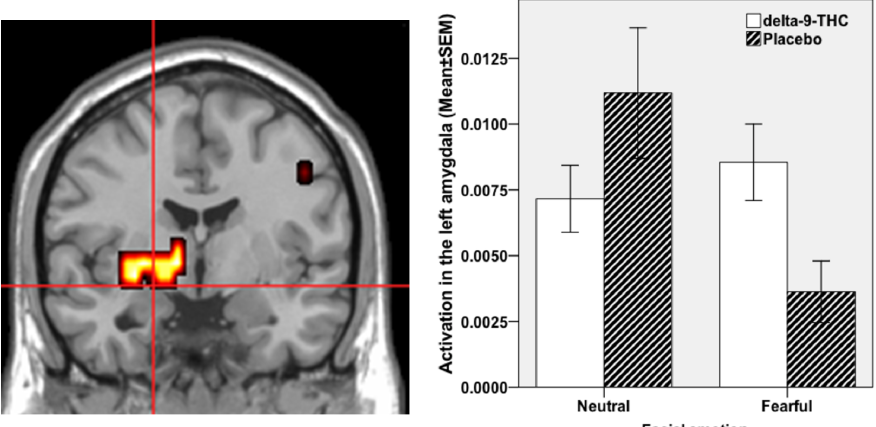
Figure 1. Brain activation whilst viewing fearful faces in comparison to neutral faces under THC condition compared to Placebo. Activation shown in the left parahippocampal gyrus and amygdala (cross-hairs in the coronal view; cluster size = 18 voxels; Talairach coordinates: x = −29, y = −4, z = −7; x = −29, y = 7, z = −13; p < 0.003 corrected for <1 false positive cluster). The left side of the brain is shown on the left side of the image. Accompanying plot on the right shows activation in the amygdala under the different fear (fearful vs neutral faces) and drug (THC vs PLB) conditions.